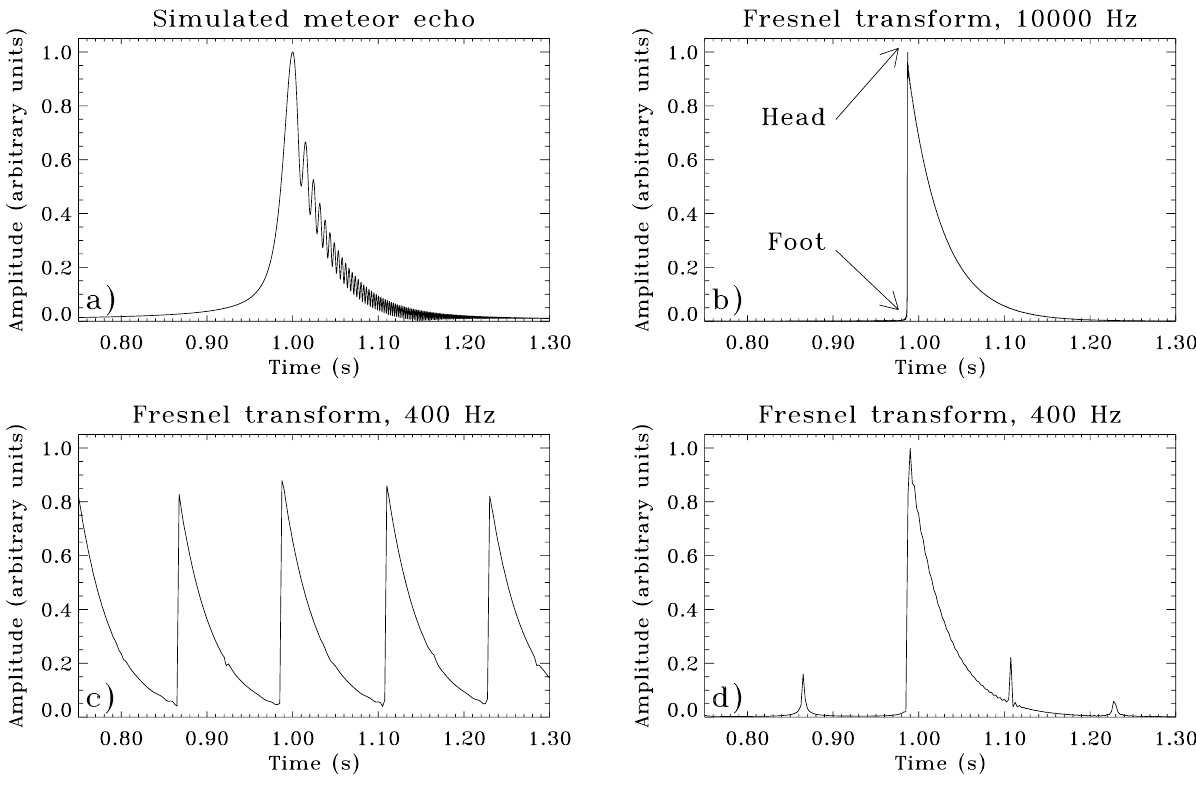
Fig. 2. (a) Simulated meteor echo and (b) it’s Fresnel transform for a 31MHz radar and meteoroid speed of 40kms − 1 , range 100km, sampling time 0.0001s, and time-series duration 2s. The labels “head” and “foot” indicate the positions of the head and foot, respectively, of the transformed echo. (c) shows the transform produced when the initial time-series is resampled at 0.0025s, illustrating overlapping echoes. (d) shows the transform produced by using weighting function